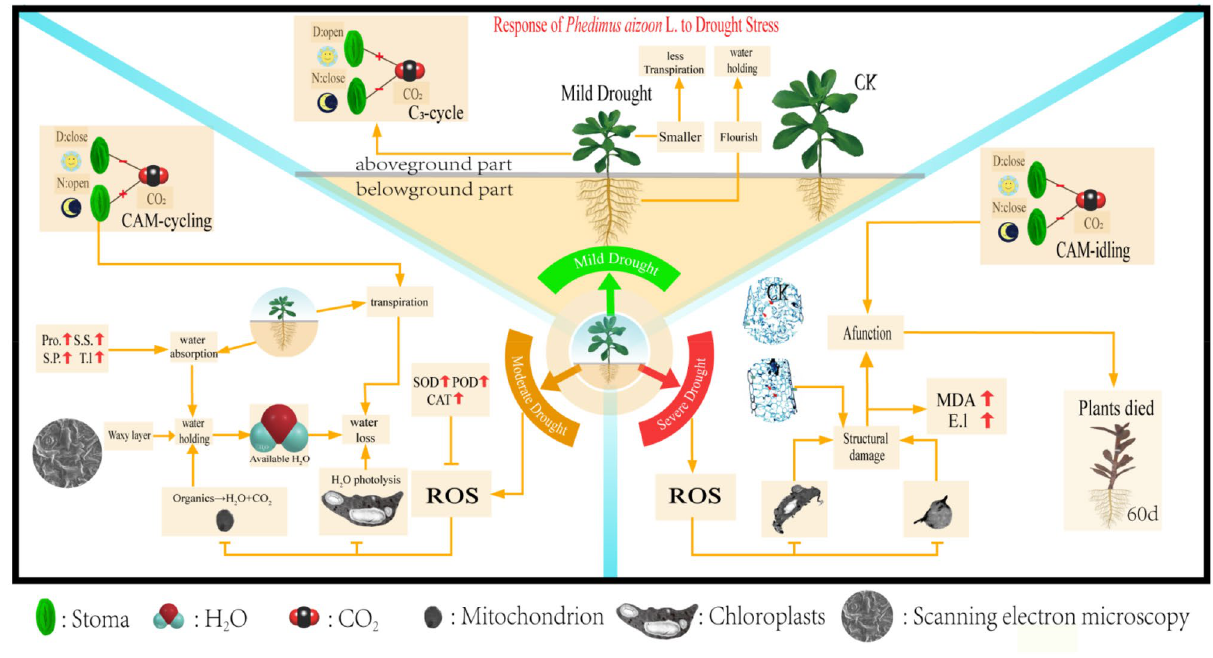
Figure 12. Response of Phedimus aizoon L. to drought stress. D, day; N, night; Pro, proline; S.S., soluble sugars; S.P., soluble protein; T.l., trehalose; MDA, malonaldehyde; E.l., electrolyte leakage; ROS, reactive oxygen